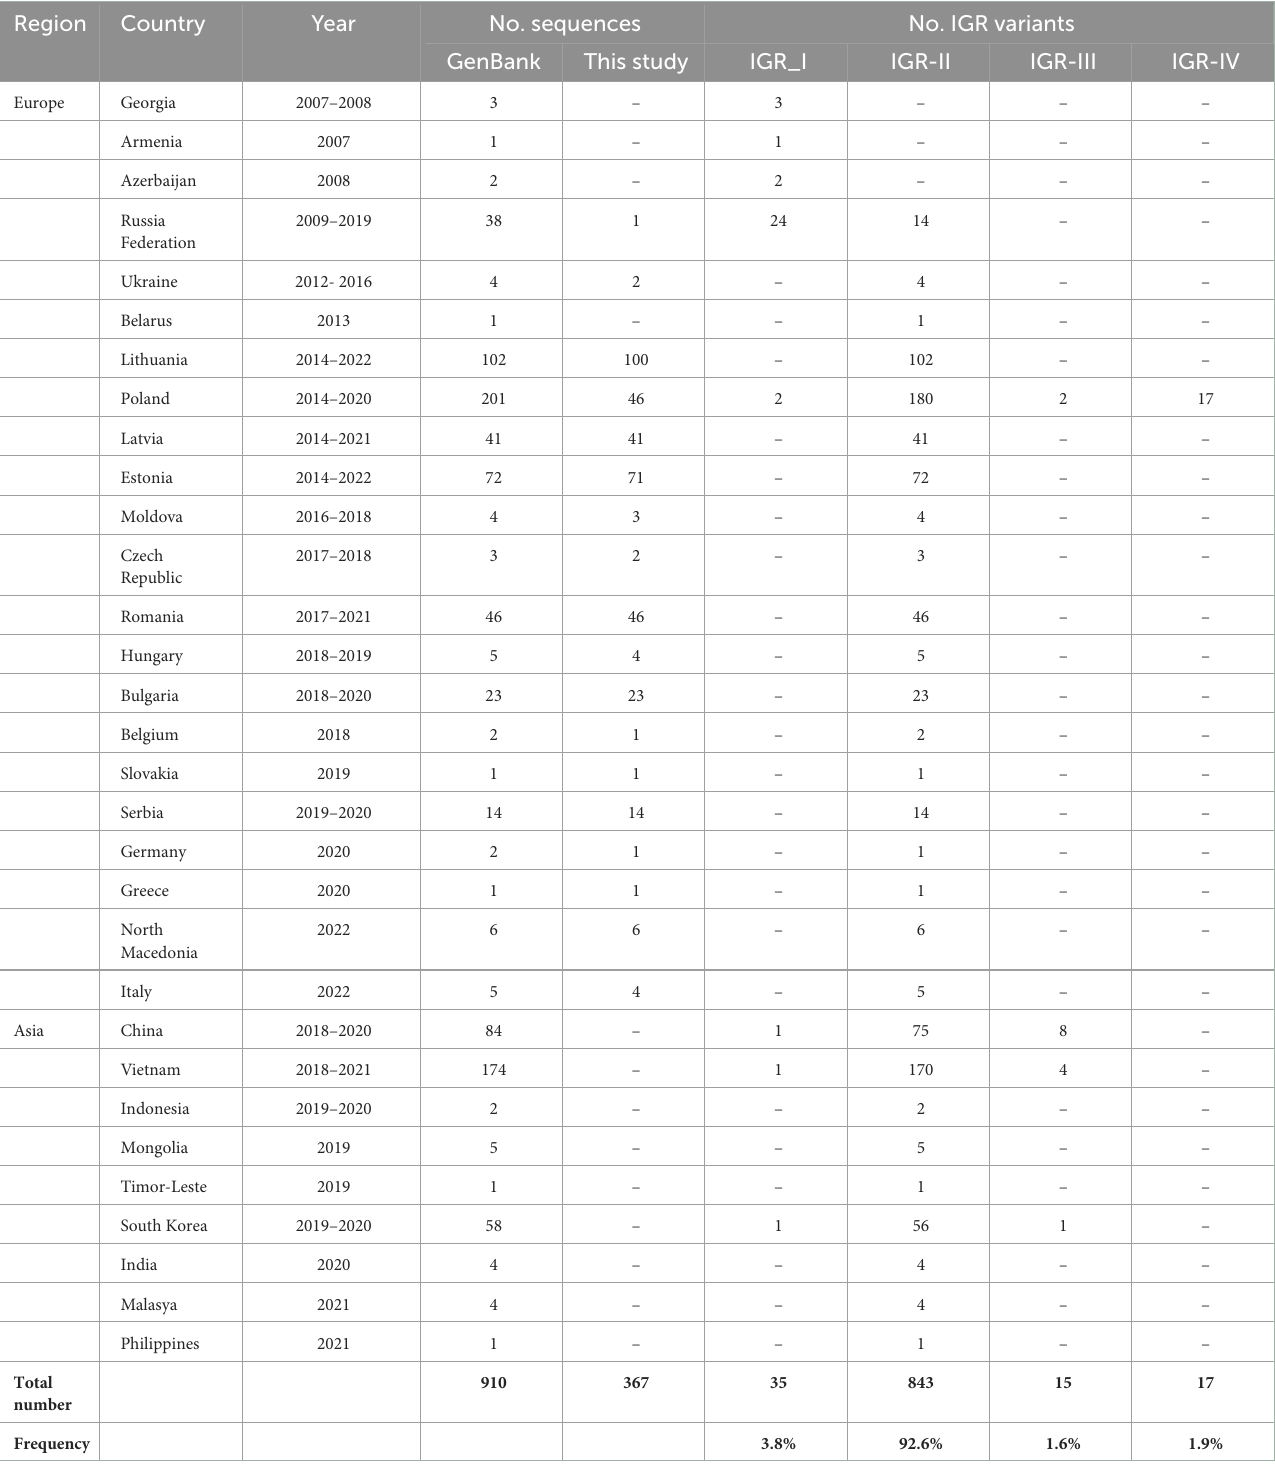
TABLE 2 IGR variants identified in 910 genotype II ASFVs from Europe and Asia. Region